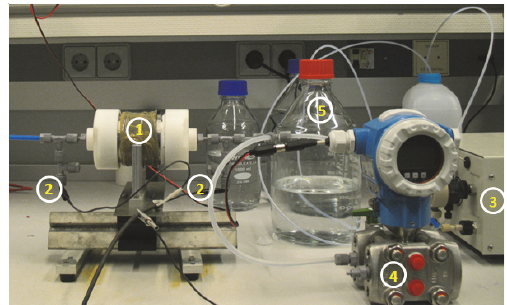
Figure5:Experimentalsetupforstreamingpotentialmeasurements described in [35, 36]. (1) Core holder; (2) Ag/AgCl electrodes; (3) pump; (4) pressure transducer; (5) solution container.